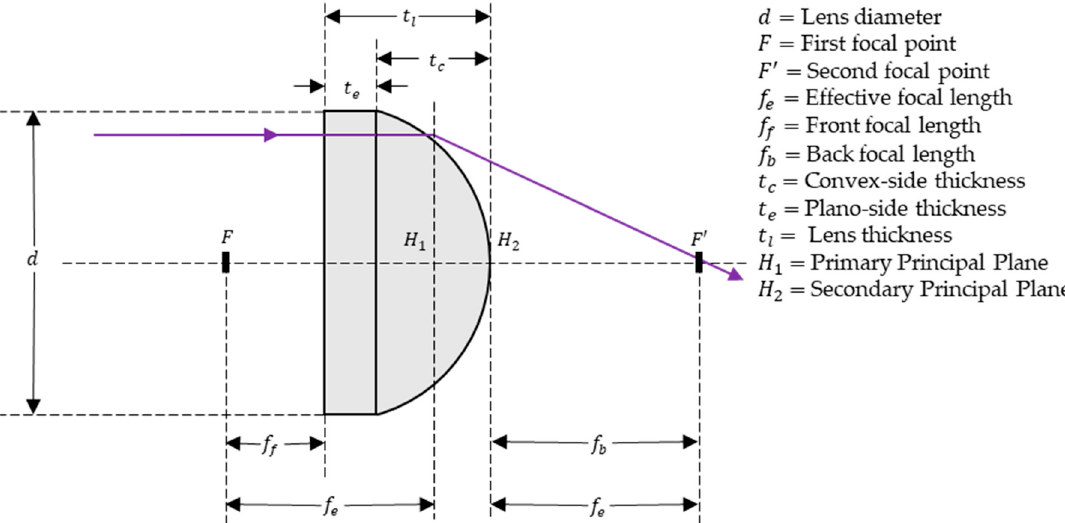
Figure 2. Characteristics of the plano-convex microlens.